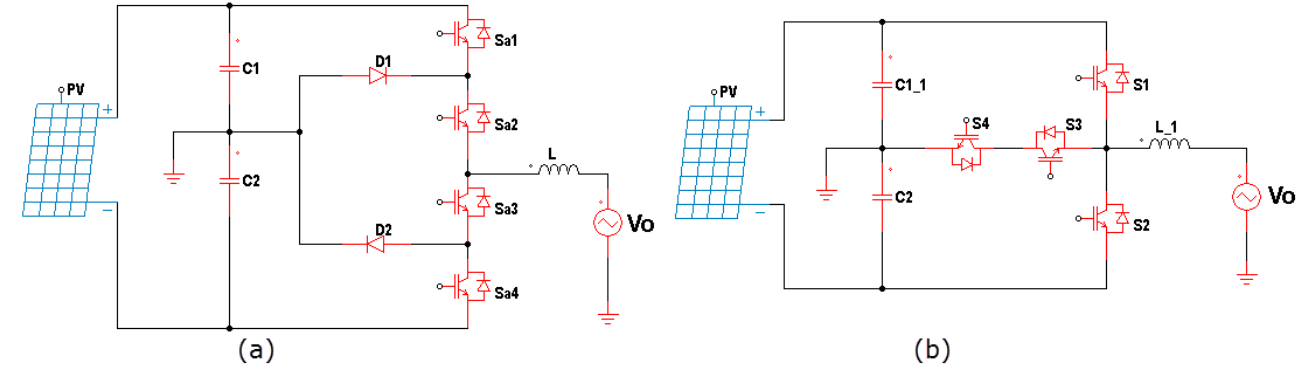
Figure 1. Single-phase three-level ( a ) NPC MLI ( b ) T-MLI.